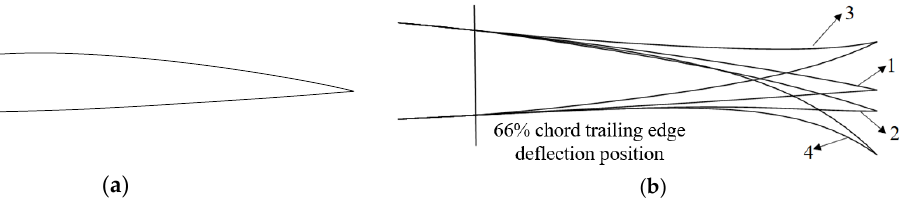
Figure 6. Initial trailing edge shapes of the four airfoils: ( a ) NACA 2412 reference airfoil; ( b ) shape of trailing edge.